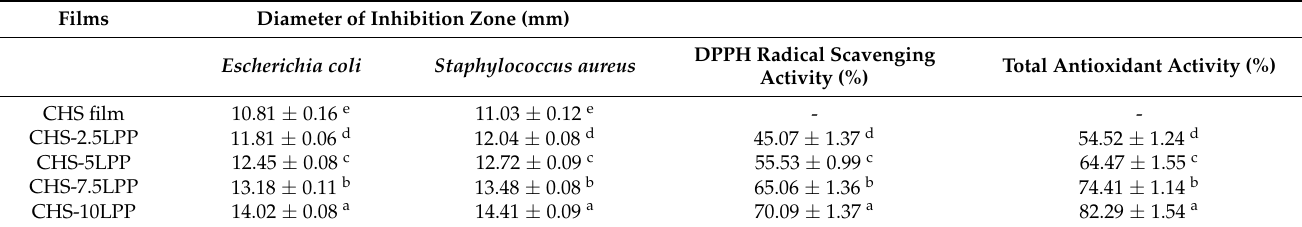
Values are expressed as mean ± standard deviation. Different letters in the same column indicate significantly different ( p <